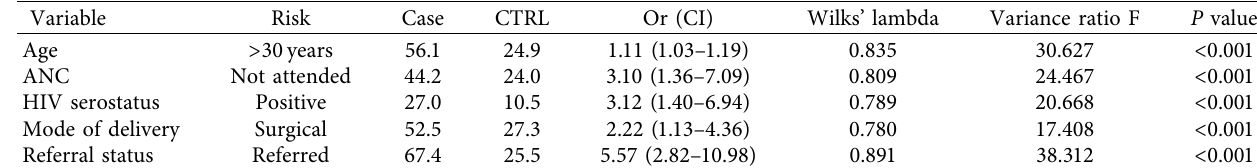
Table 4: Logistic regression analysis and discriminant analysis.